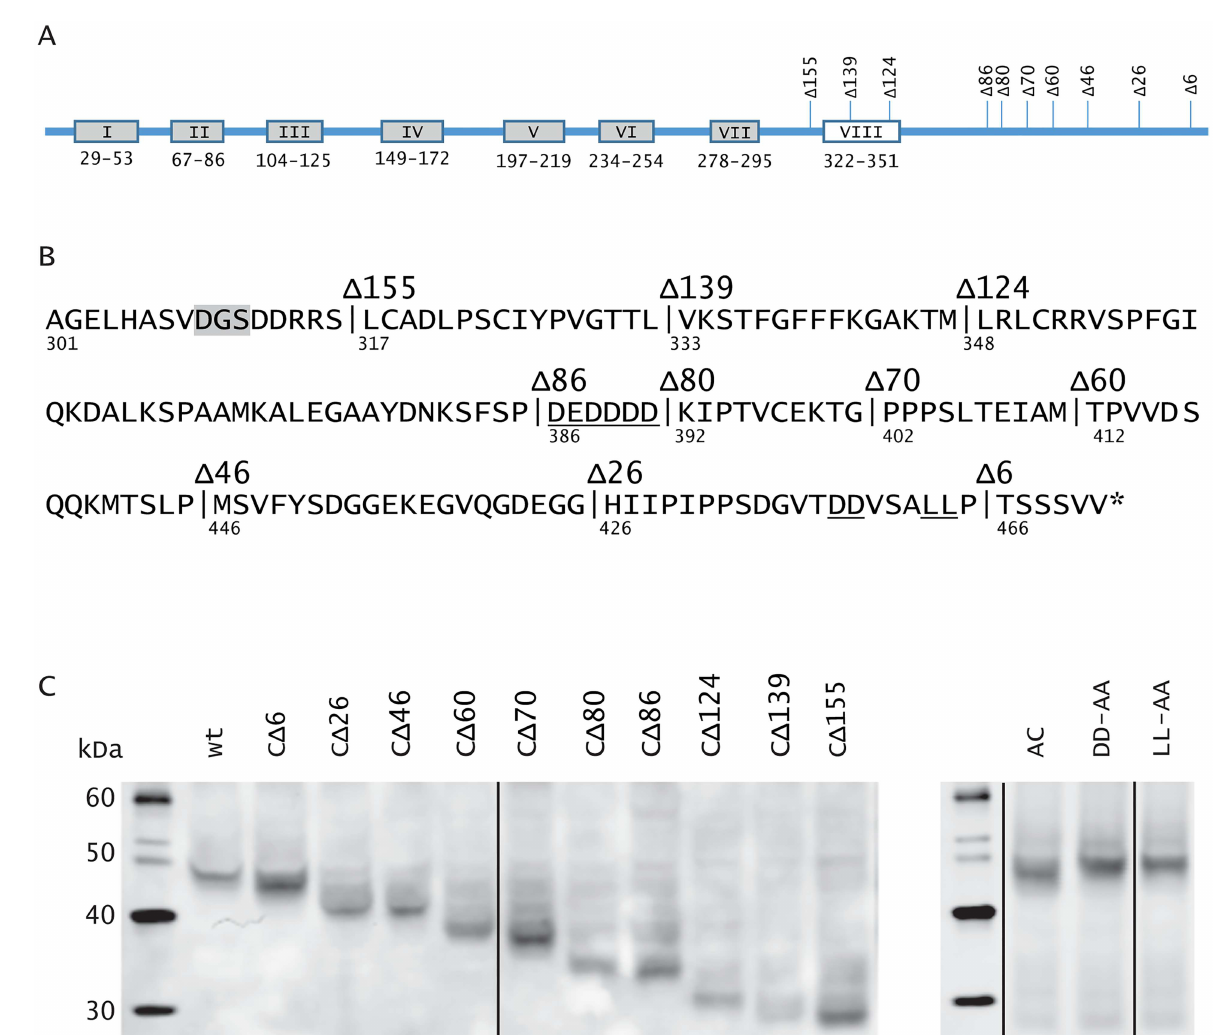
Fig 2. Western blot detection of mutated M78 constructs. Panel A shows a schematic depictionof M78 with boxes indicating positionsof the seven predicted transmembrane domains (grey) and putative 8 th membrane-associated helix (white); positions of the various truncationmutants are also shown. Secondary structure predictionsmade via the PredictProtein server [32]. Panel B shows the M78 C-tail amino acid sequence, numbering beneath indicatesamino acid position. Vertical lines, with their designations above, indicate positionsof truncations. Positions of amino acid substitutions are underlined, namely of the acidic cluster (DEDDDD) and the acidic di- leucine (DDvsaLL). The position corresponding to the SalI site used for certain plasmid constructs is boxed in grey. Panel C shows immunoblot analysis of the various constructs. Hela cells were transfected with plasmidsexpressing HA-tagged M78, either wild type (wt), C-terminally truncated (C Δ 6—C Δ 155) or amino acid substitutions disruptingthe acidic cluster 386 DEDDDD 391 (AC: VQNAAA) or the acidic dileucinemotif 458 DDxxxLL 464 (DD-AA or LL-AA). One day post-transfection, cells were harvested and analysedby western blotting, using a mouse monoclonal anti-HA antibody. The marker band sizes are shown (in kDa). The truncation and substitution mutants were analysedon different gels; vertical black lines indicate where the gel images were spliced to remove irrelevant